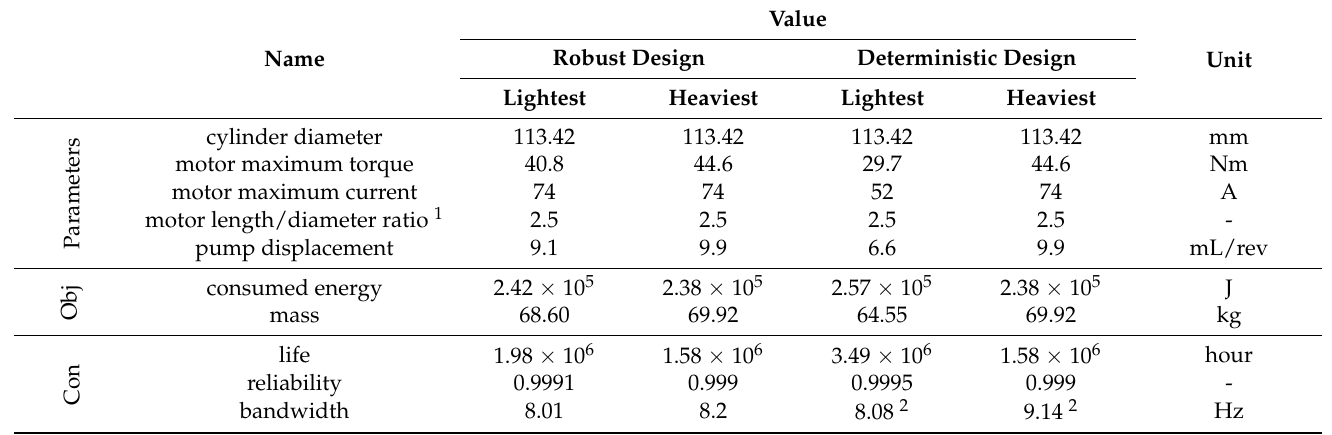
Table 3. The lightest and heaviest designs of the pareto fronts.